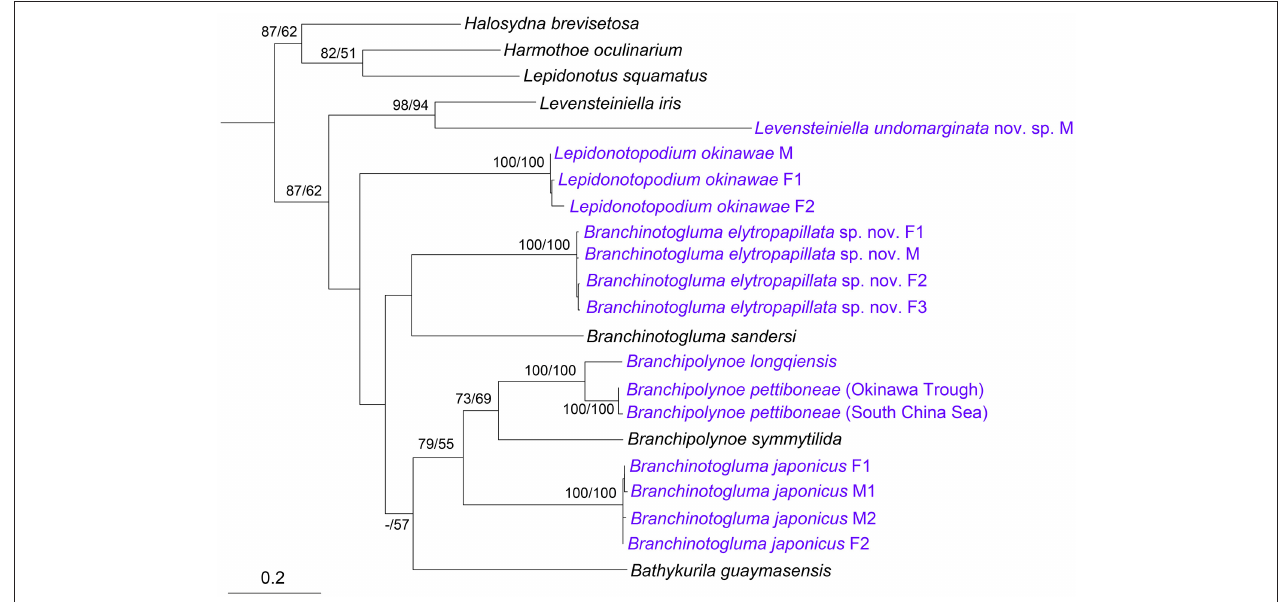
FIGURE 9 | Phylogenetic tree constructed using COI sequences. Numbers above branches represent ML/MP bootstrap values with 100 as the highest value. M, male; F, female. Species we sequenced were marked as blue. The subfamilies are shown on the right. Accession numbers: Harmothoe oculinarum , AY894314; Halosydna brevisetosa , AY894313; Lepidonotus squamatus , AY894316; Bathykurila guaymasensis , DQ074766; Branchinotogluma sandersi , JN852923; Branchipolynoe symmytilida , AY646021; Levensteiniella iris , KY753827; Branchipolynoe longqiensis , KY753826; Branchipolynoe pettiboneae , KY753825